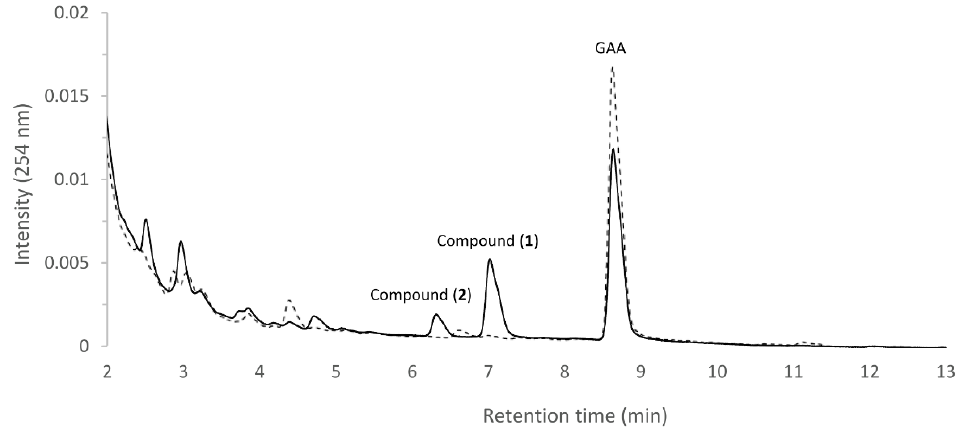
Figure 1. Biotransformation of ganoderic acid A (GAA) by B. subtilis ATCC (American type culture collection) 6633. The strain was cultivated in modified glucose-nutrient (MGN) media containing 0.02 mg/mL of ganoderic acid A (GAA). The initial cultivation (dashed line) and the 72 h cultivation (solid line) of the fermentation broth were analyzed with ultra-performance liquid chromatography (UPLC). The UPLC operation conditions are described in the Materials and Methods section.